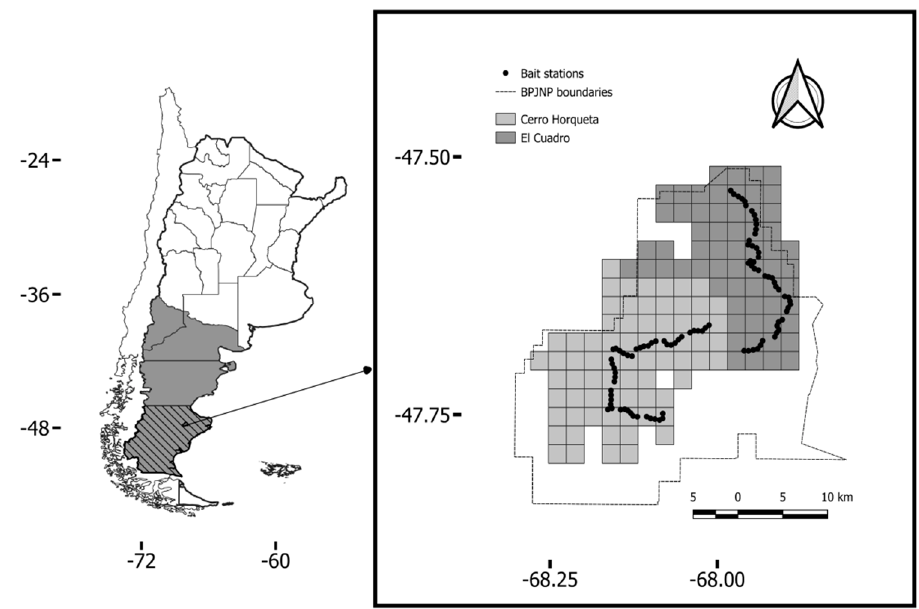
Figure 1. Left: Location of the Bosques Petrificados de Jaramillo National Park (BPJNP) in the Santa Cruz province (grey region with oblique bars), southern Argentine Patagonia (grey shaded regions). Right: spatial distribution of bait station lines designed for fox population monitoring (black dots), and sampled grids for monitoring the puma population in each abandoned sheep ranch.